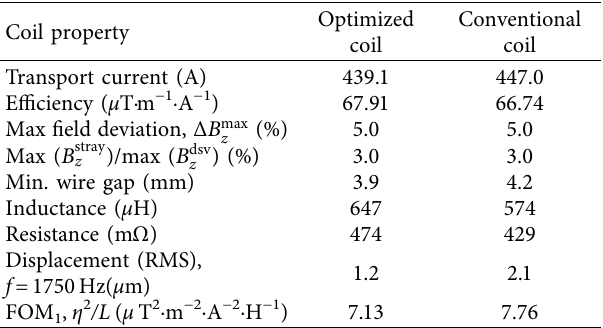
Table 1: Characteristics of the designed